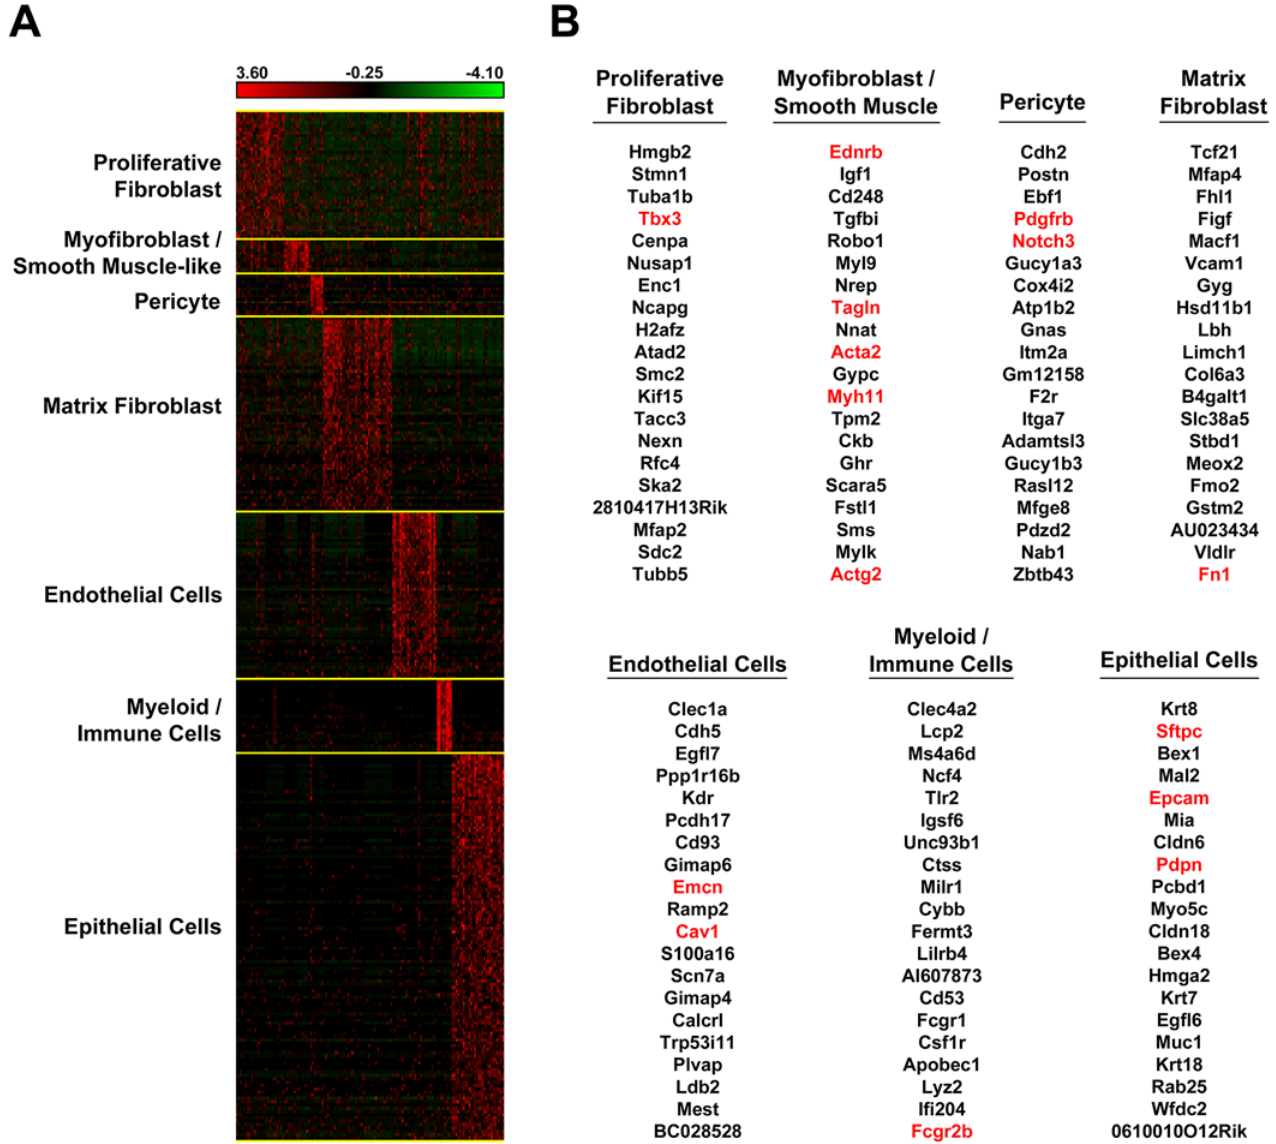
Fig 5. Predicted Signature Genes for Major Lung Cell Types. (A) Heatmap shows that the predicted cell type specific signature genes are selectively expressed in defined cell types. Gene expression was per sample z-score normalized. (B) The top 20 signature genes based on the ranking scores for each lung cell type are listed. Genes in red are the known markers that were used to train the signature prediction